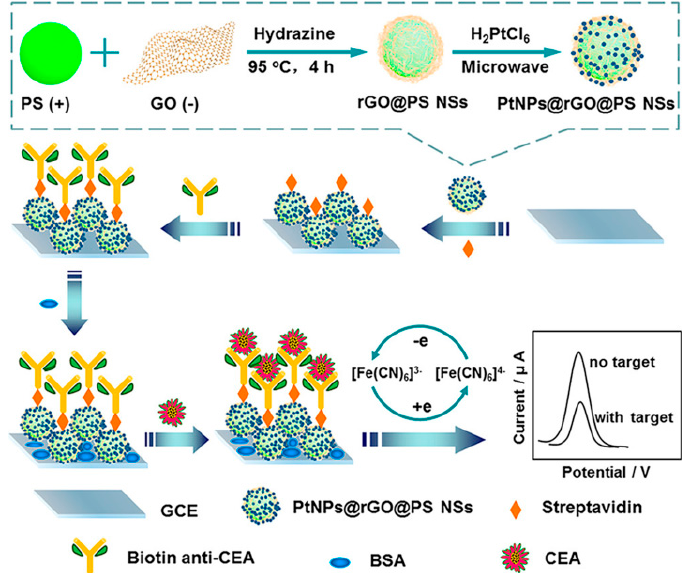
Figure 2. Schematic illustration of the preparation process for PtNPs@rGO@PS NSs and the fabrication of the electrochemical label-free immunosensor. Reprinted with permission from ref.